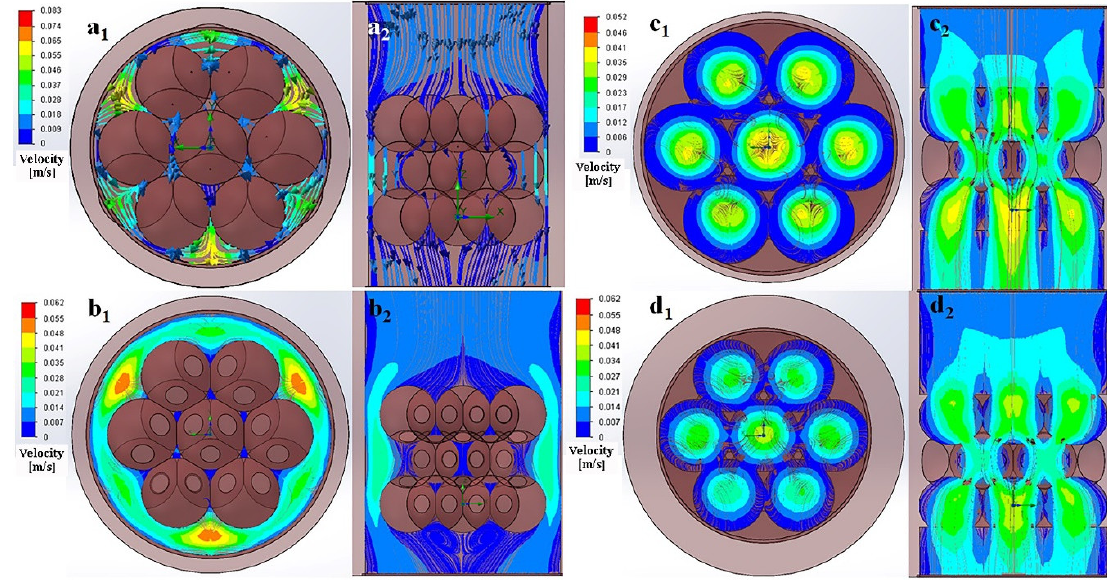
Figure 6. CFD fluid simulation analysis of HASAs and HAPPS scaffolds reveal the relationship between distribution of flow field and macropore size. The distribution of flow field on the horizontal plane in: L-HASAs ( a 1 ), S-HASAs ( b 1 ), L-HAPPs ( c 1 ), S-HAPPs ( d 1 ). The distribution of flow field on the sagittal plane in: L-HASAs ( a 2 ), S-HASAs ( b 2 ), L-HAPPs ( c 2 ), S-HAPPs ( d 2 ). Color bar shows flow velocity.